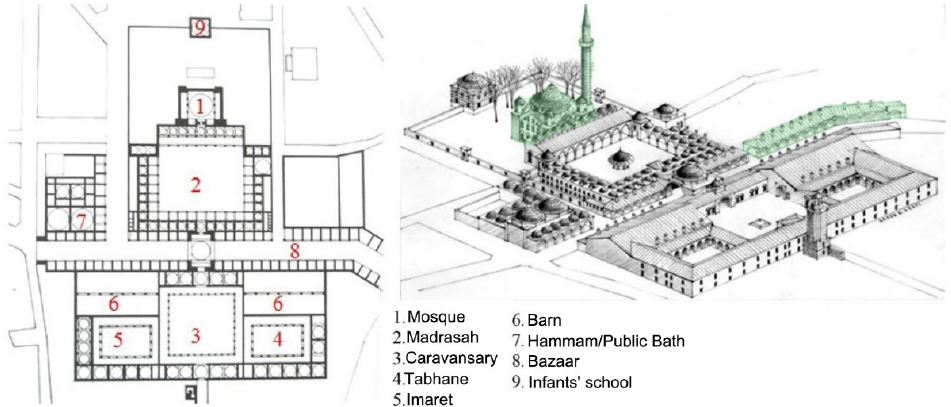
Figure 3. Sokullu Mehmet Pa ş a Külliyesi, with the colored areas indicating the mosque and commercial buildings (adapted with permission from Necipo ğ lu 2005).